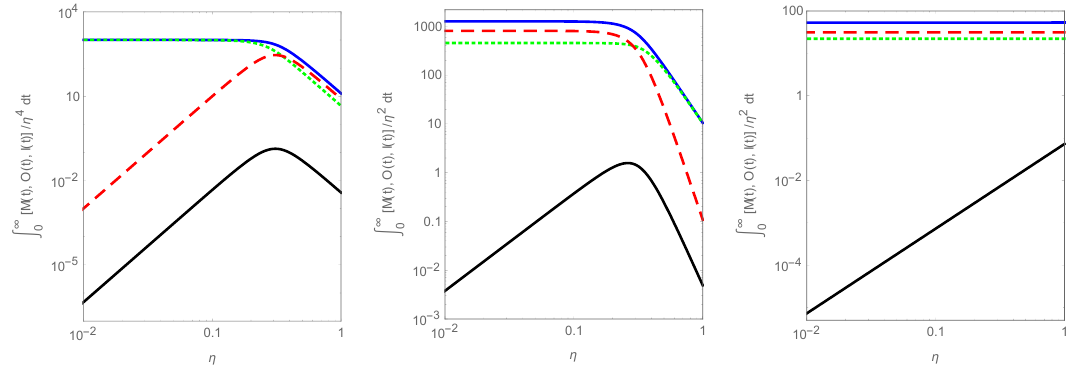
Figure 1 . Behavior of CP odd quantities for small Yukawa couplings and mass (cid:12) (cid:12) (cid:12)R ∞ (cid:12) (cid:12) (cid:12)R ∞ splittings, namely M ( t ) d t O ( t ) d t (cid:12) / ( M 4 1 η a ) (solid blue lines), (cid:12) / ( M 4 1 η a ) (dot- 0 0 (cid:12) (cid:12)R ∞ (cid:12) ted green lines), I ( t ) d t (cid:12) / ( M 4 1 η a ) (dashed red lines), and the CP asymmetry 0 (cid:12) (cid:12) (cid:12) (cid:12)R ∞ (cid:12) R ∞ 2 ( t )] /N d t (cid:12) (cid:12) ¯ A (cid:12) (cid:12) [ | A | 2 ( t ) − / ( M 4 η a ) = M ( t ) + O ( t ) + I ( t ) d t (cid:12) (cid:12) (cid:12) / ( M 4 1 η a ) (thick solid black (cid:12) (cid:12) 1 0 0 lines), as a function of η , which parametrizes h 1 , 2 and (cid:15) . Note that we have normalized these quantities to M 4 to make them dimensionless and to a certain power of η so that the mixing and 1 oscillation contributions be constant in the limit η → 0 ( a = 4 in the left plot, and a = 2 in the middle and right plots). For all plots we have chosen h 1 /M 1 = h and h 2 /M 1 = ( h/ 2) e iπ/ 4 , while 1 h = η and (cid:15)/M 2 = 1 in the left plot, h = 1 and (cid:15)/M 2 = 10 1 η 2 in the middle plot, and h = η 1 1 10 16 π 16 π 1 and (cid:15)/M 2 = 1 η 2 in the right plot. 1 2 16 π